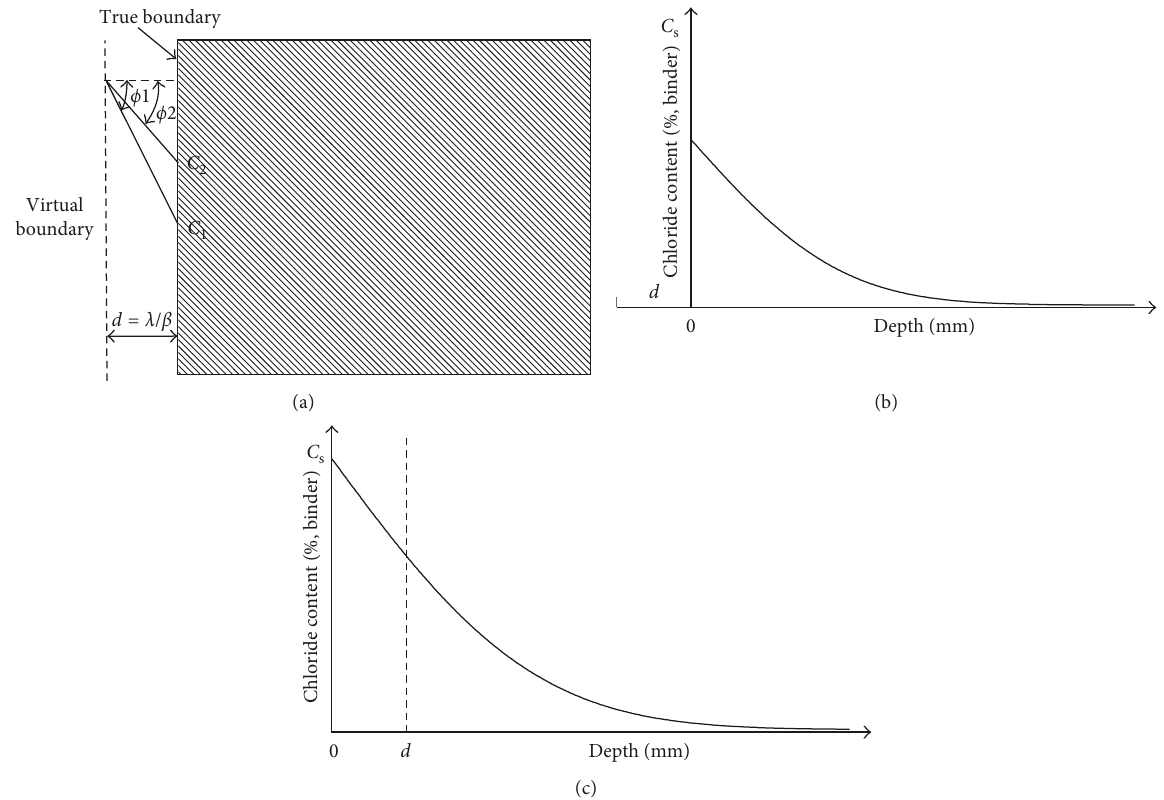
Figure 3: Explanation of the Dirichlet boundary condition and Neumann boundary condition: (a) approximate treatment of the Neumann boundary condition; (b) chloride profile of the Neumann boundary condition; (c) chloride profile of the Dirichlet boundary condition.